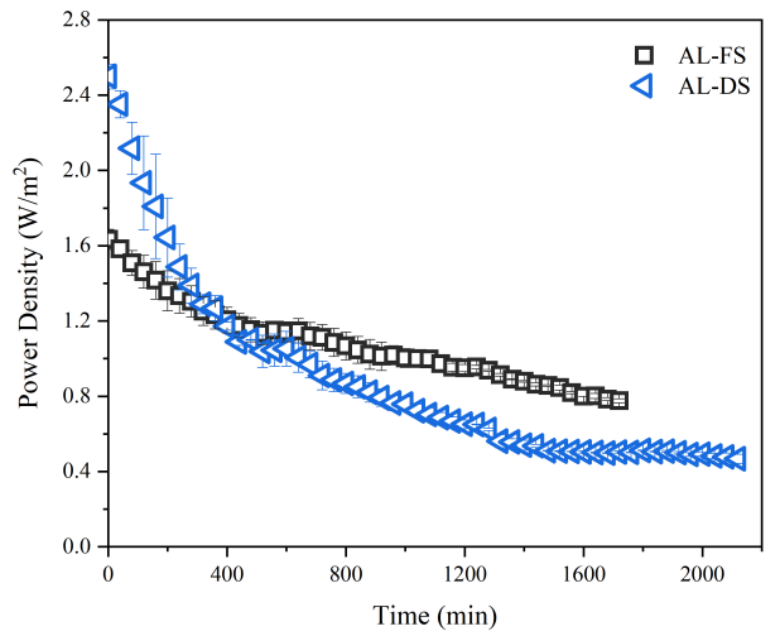
Figure 3. The variation of power density at both AL-FS and AL-DS membrane orientations.